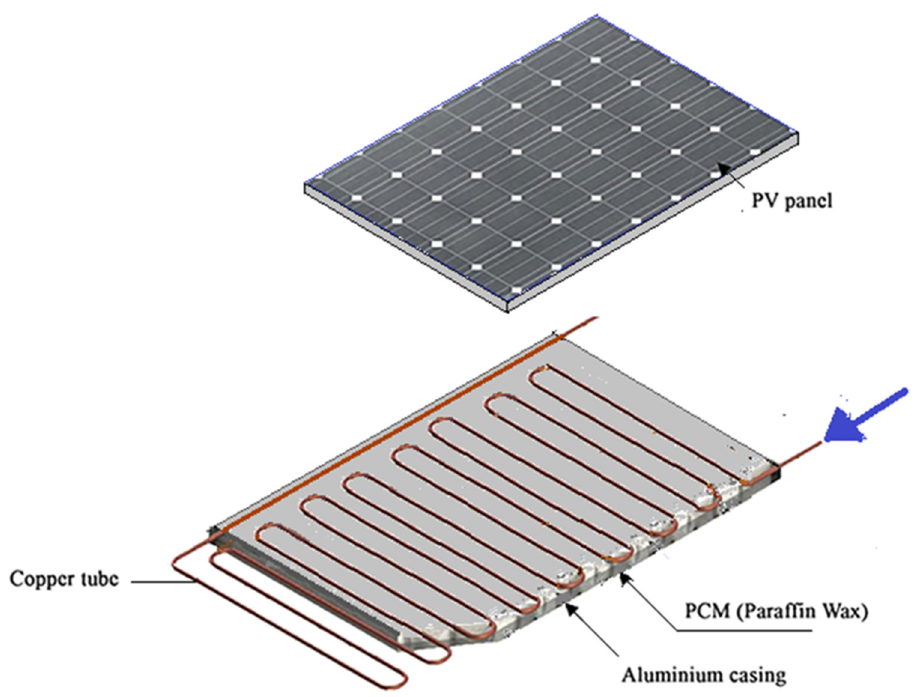
Figure 11. Diagram of the water-based PVT system studied by Maatallah et al. [38].